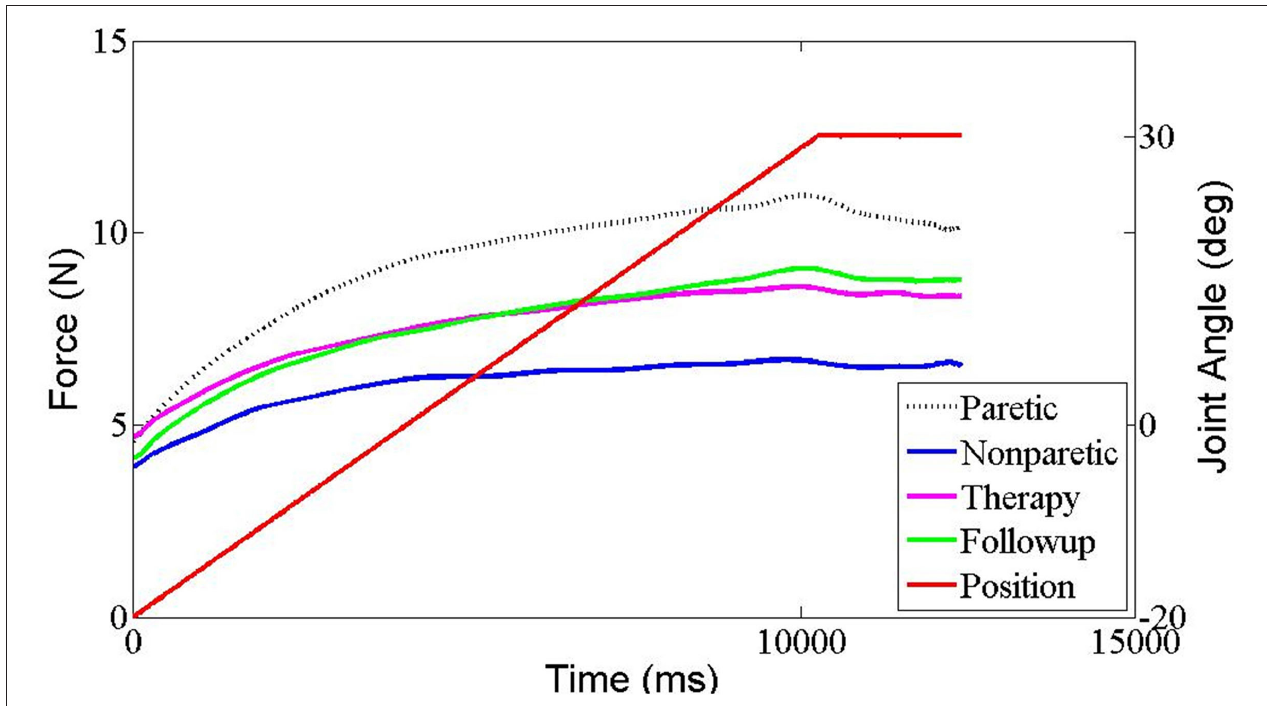
FIGURE 5 | The typical resistant force trend curve in each measurement situation recorded by Neuroflexor in one stroke patient. Red trace represents the angle of wrist movement (from flexion to extension). Black dashed trace represents resistant force of paretic side, Blue trace represents resistant force of non-paretic side, pink trace represents resistant force immediately after ESW intervention of paretic side and green trace represents resistant force at 1 week later of paretic